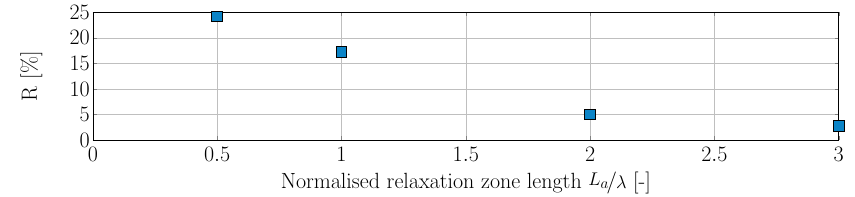
Figure A3. Reflection coefficient over different relaxation absorption zone lengths L a